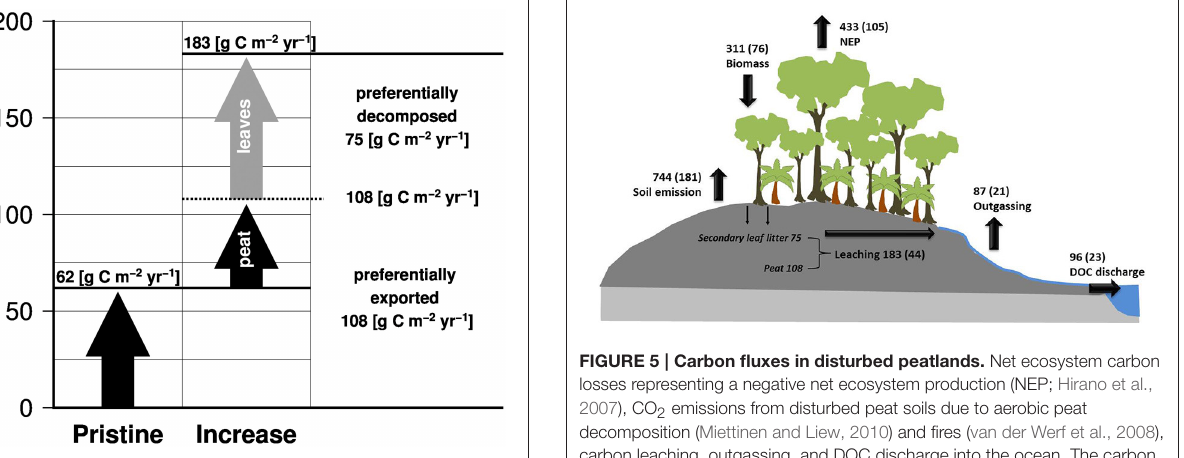
FIGURE 4 | Leaching of organic carbon from pristine peat soils and the additional leaching caused by human impacts subdivided according to DOC sources (peat soil and leaf litter).